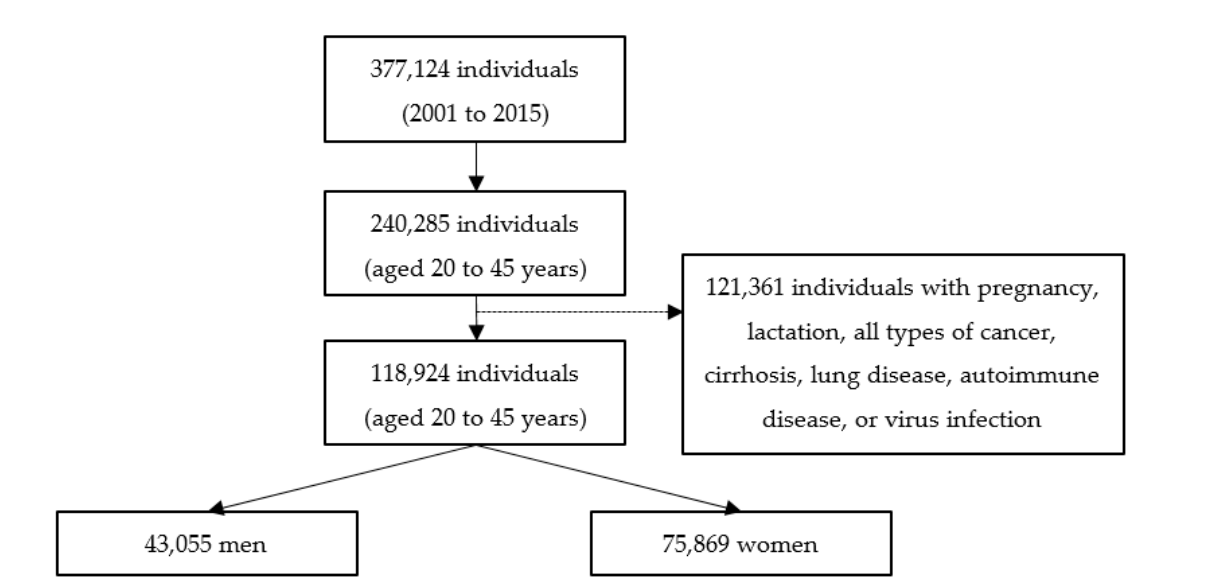
Figure 1. Flowchart of study participants.